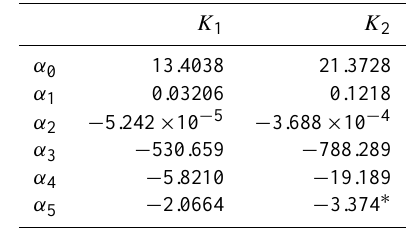
Table 13. Coefficients from Millero (2010) for formulations of K 1 and K 2 (seawater scale).